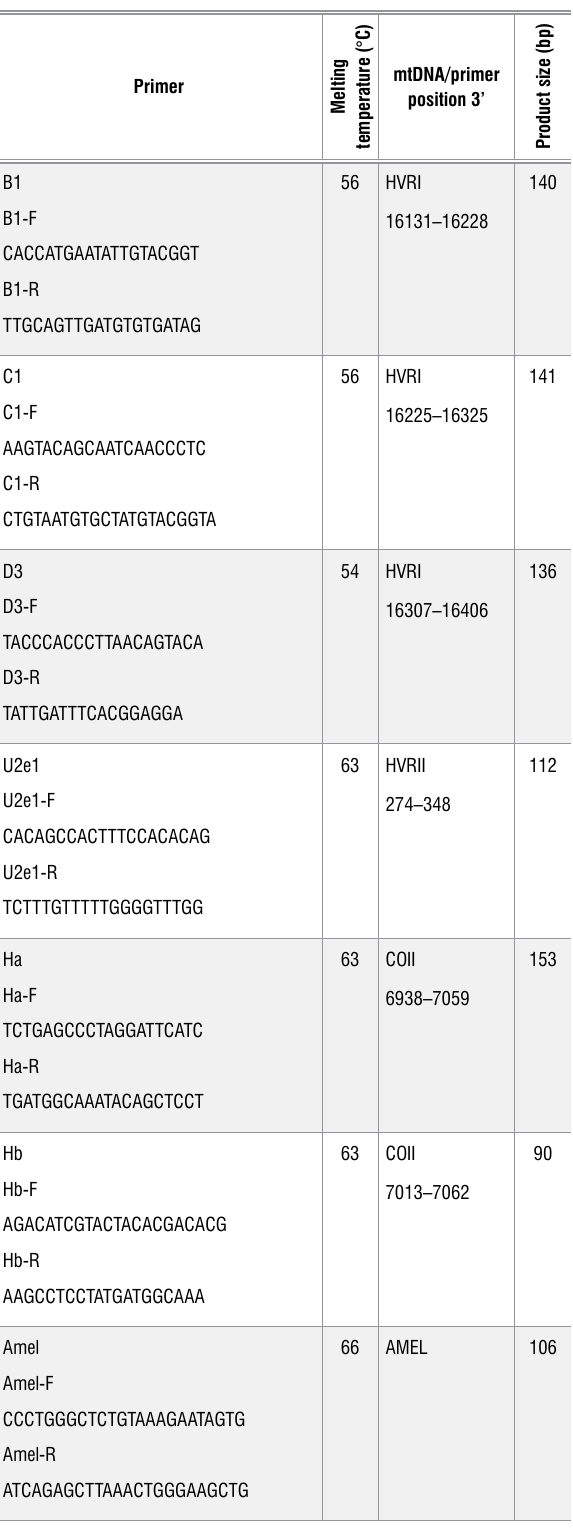
A list of the primers used, target region and expected PCR